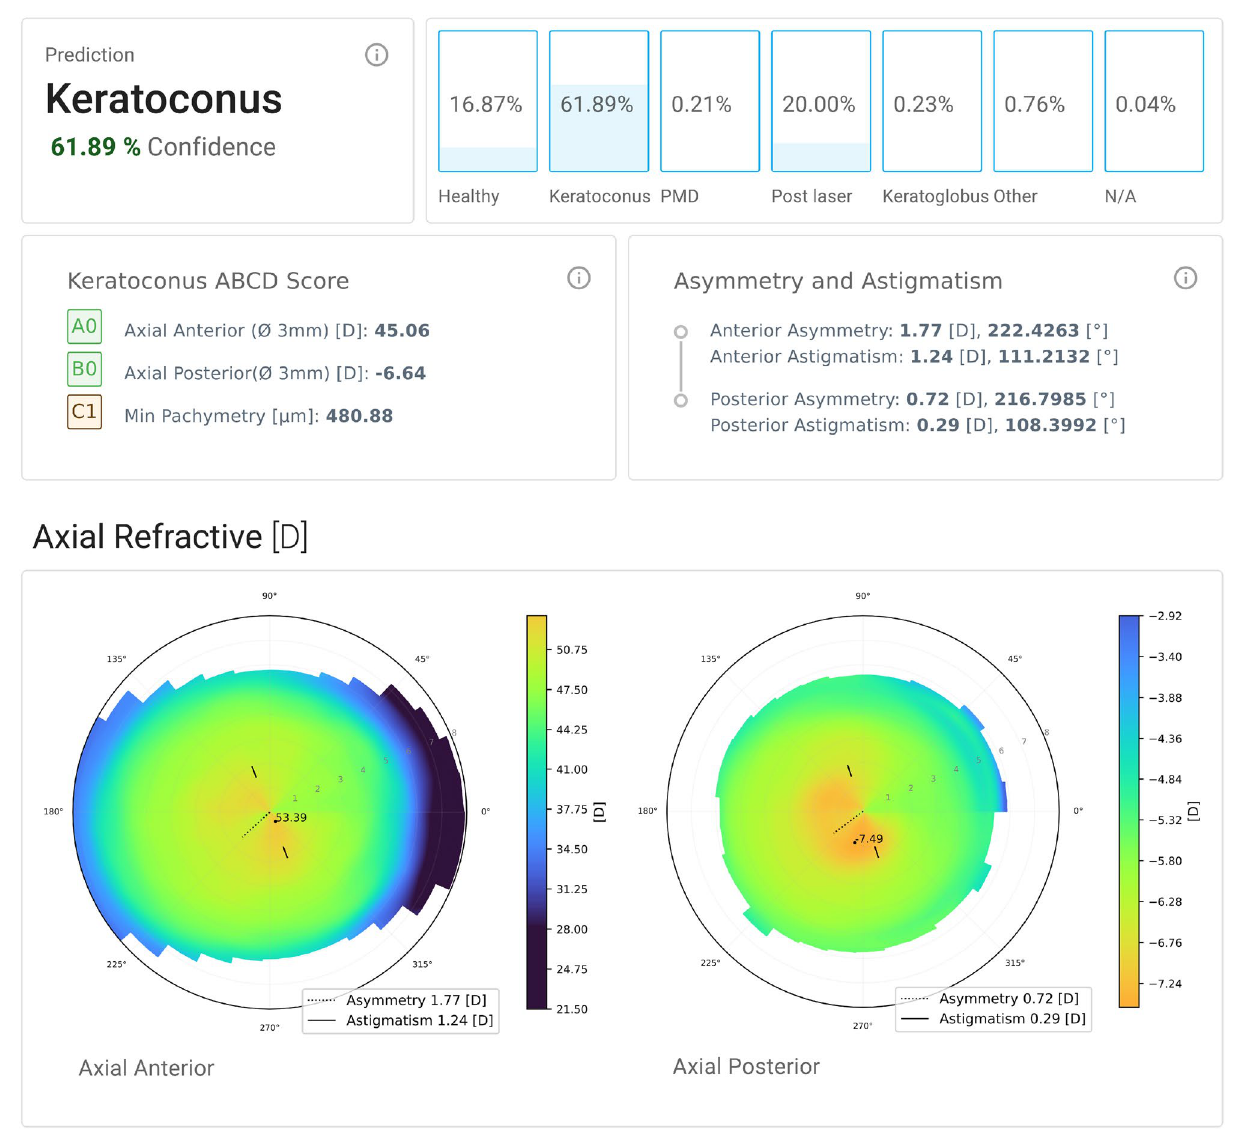
maps are generated using the same methods as the input images for the